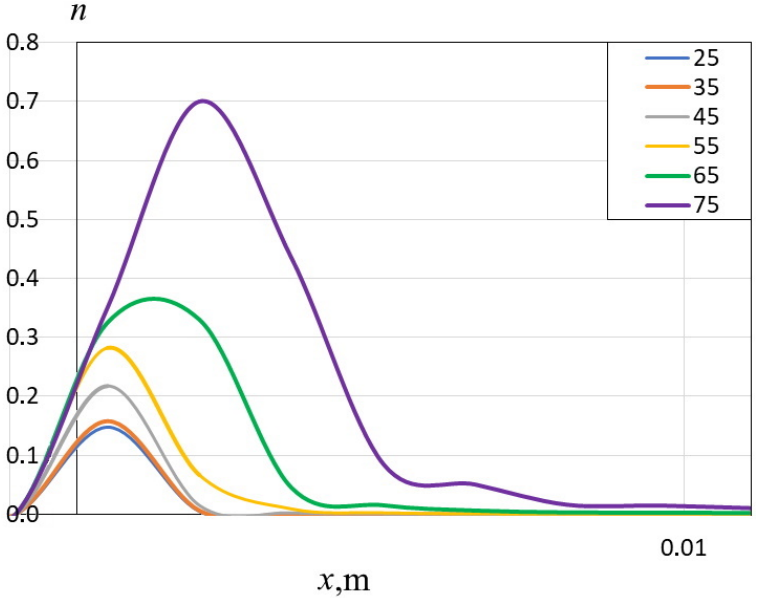
Figure 14. Vapor fraction n along the conic (diverging) nozzle at different temperatures (temperature is shown in ◦ C) (from our CFD results).